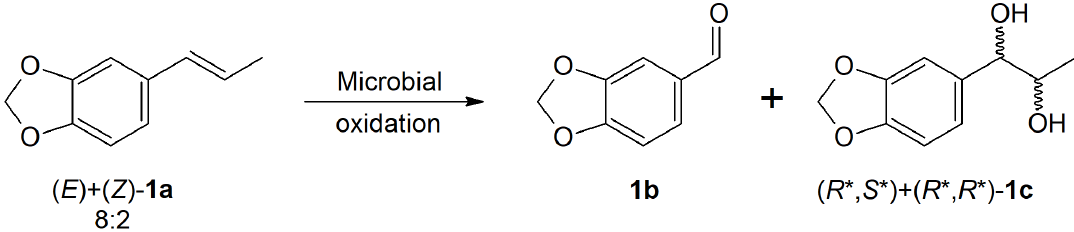
Figure 1. Products of isosafrole ( 1a ) biotransformation : piperonal ( 1b ) and vicinal diol 1c .